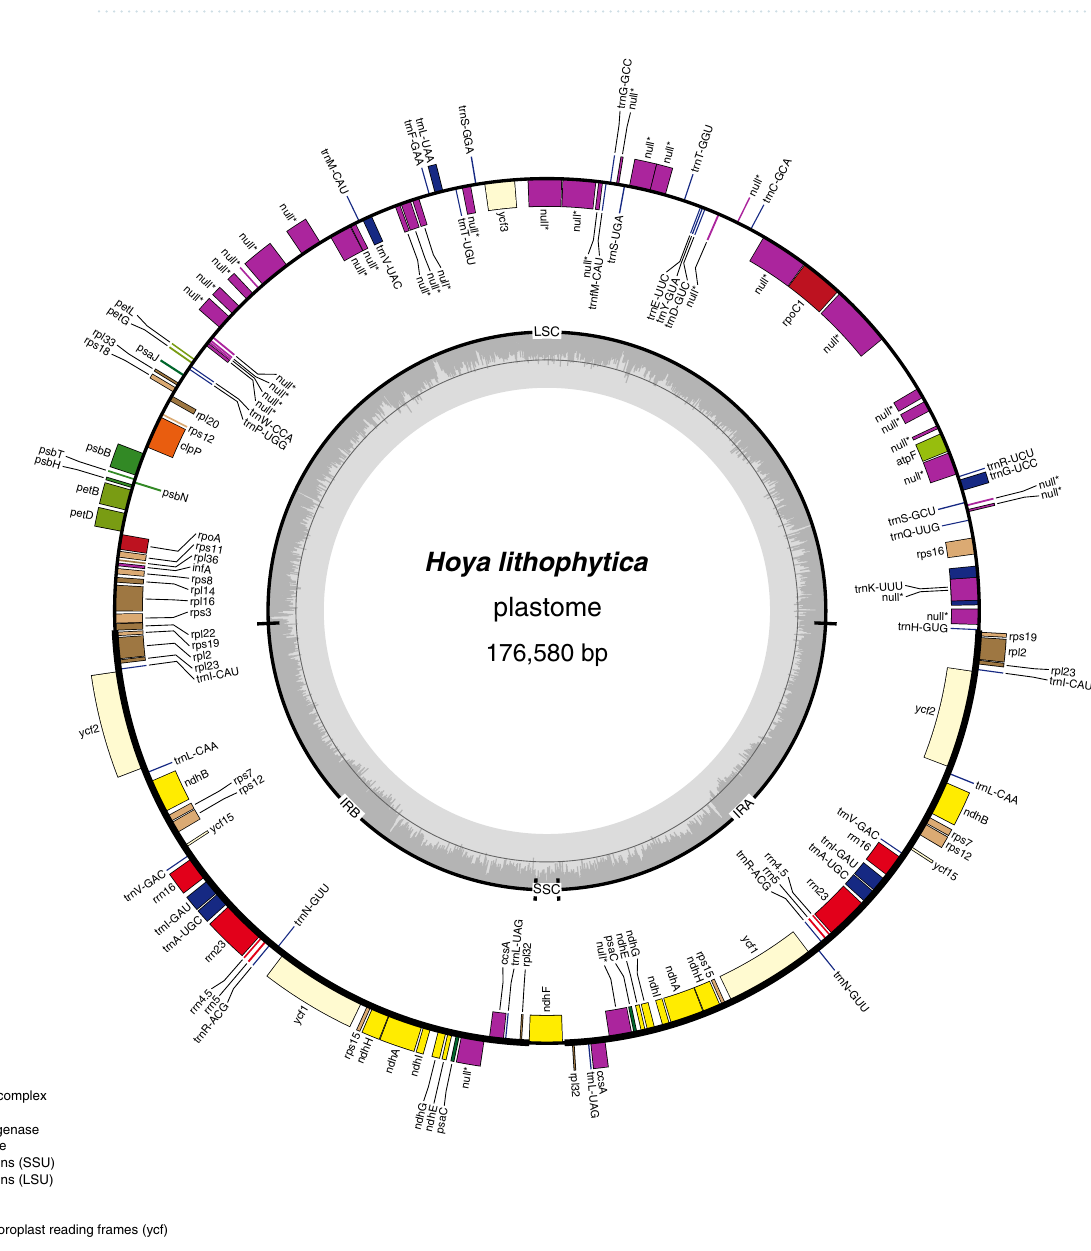
Table 1. Summary of 22 plastomes (12 complete plastomes) of 4 species of Dischidia , 14 of Hoya , 1 of Oreosparte and 1 of Papuahoya (ingroups), and two outgroups.